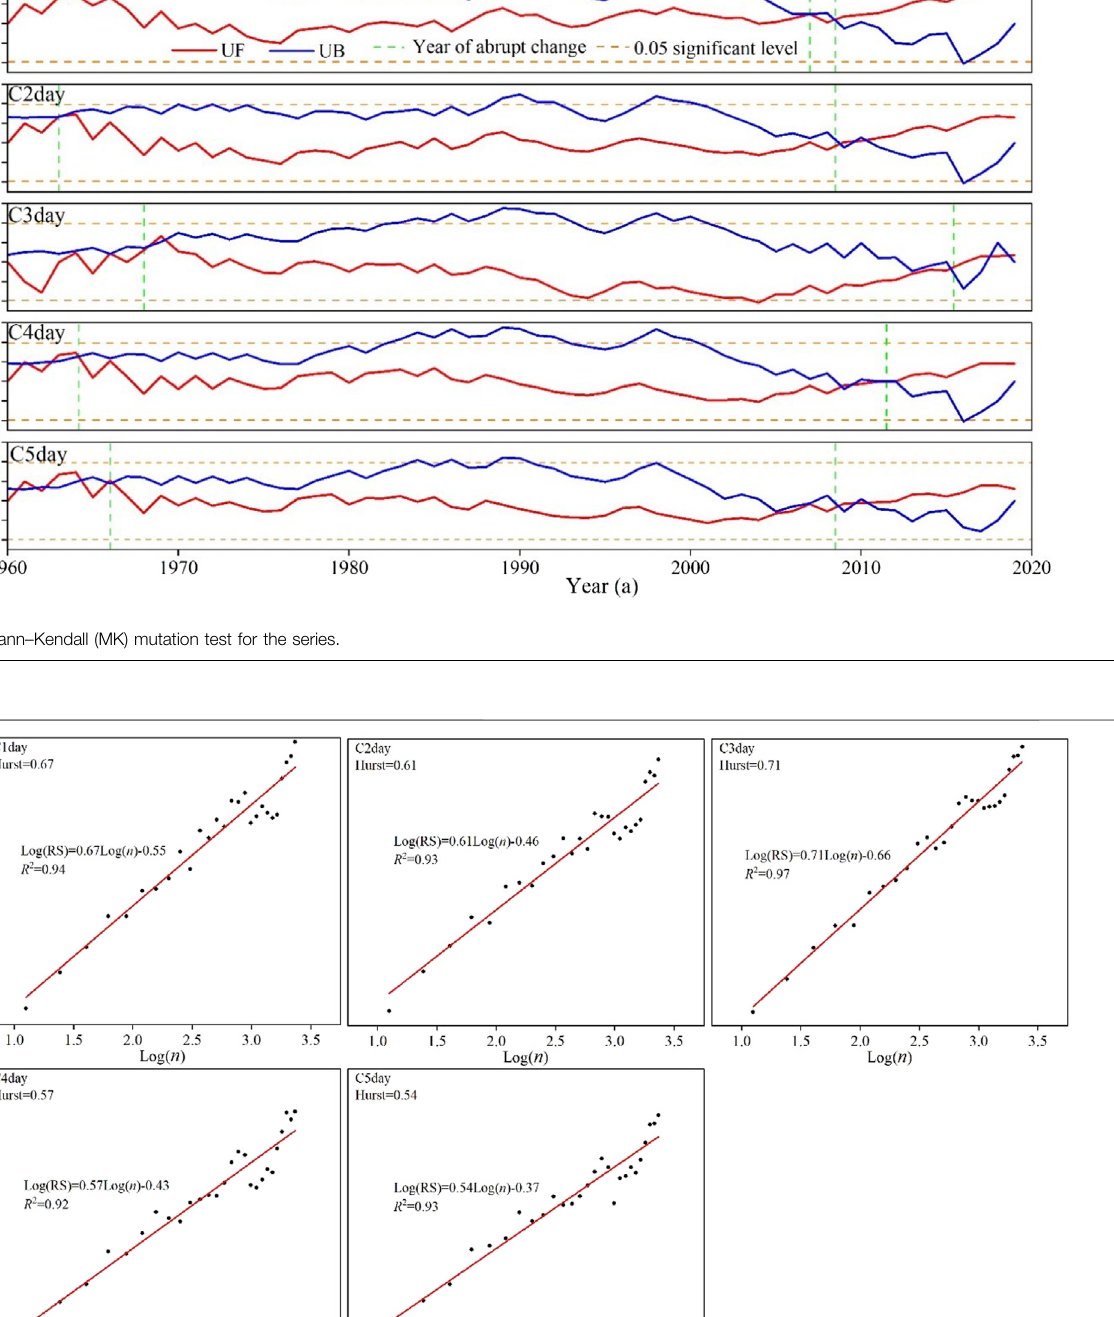
Frontiers in Environmental Science |